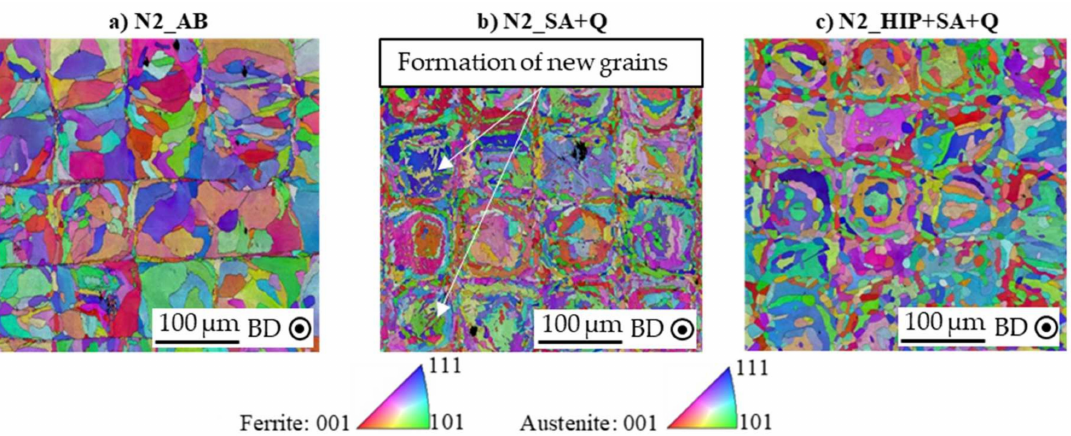
Figure 11. IPF maps of L-PBF AISI 318LN processed under a nitrogen protective atmosphere: ( a ) AB condition, ( b ) SA + Q condition, ( c ) HIP + SA + Q condition. BD: building